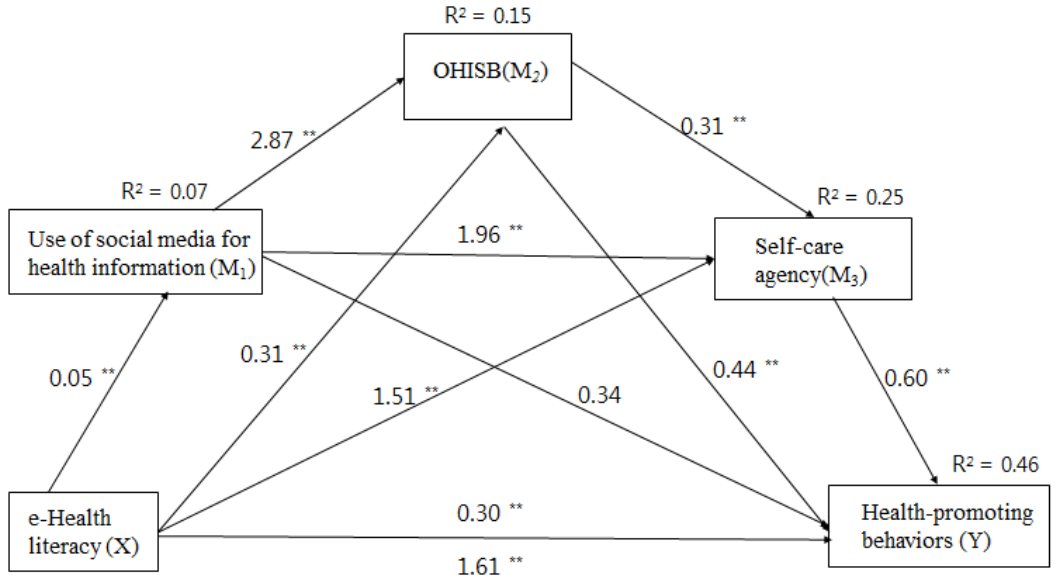
Figure 1. The results of the multiple mediation model testing social media use for health information, online health information-seeking behaviors, and self-care agency as mediators of the effect of e-health literacy on health-promoting behaviors. ** p < 0.01.